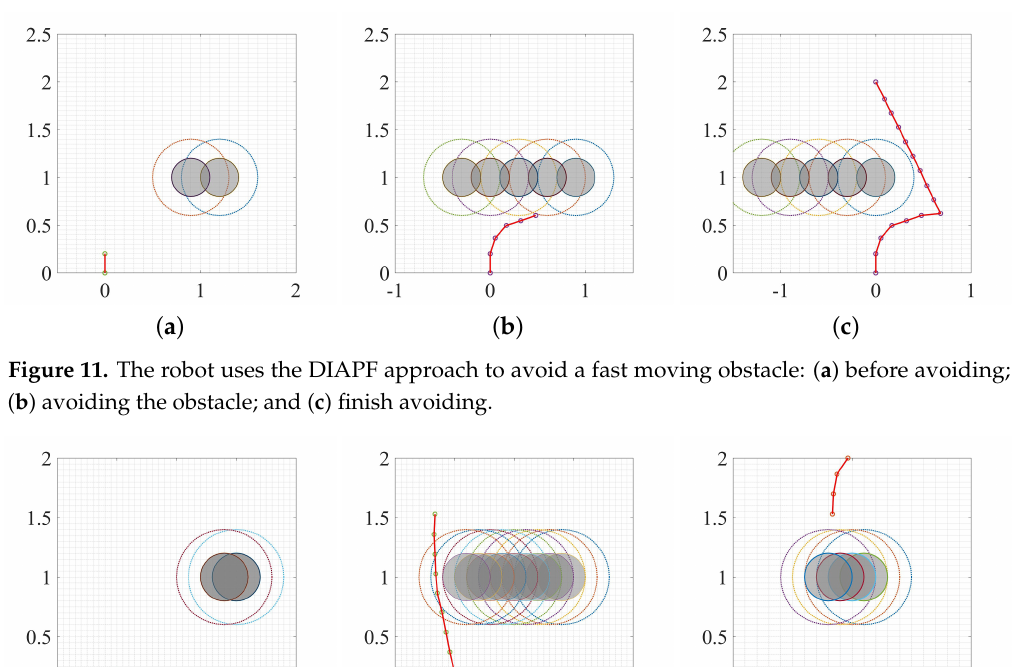
Figure 10. The robot uses the DVAPF approach to avoid a slow moving obstacle: ( a ) before avoiding; ( b ) avoiding the obstacle; ( c ) finish avoiding.